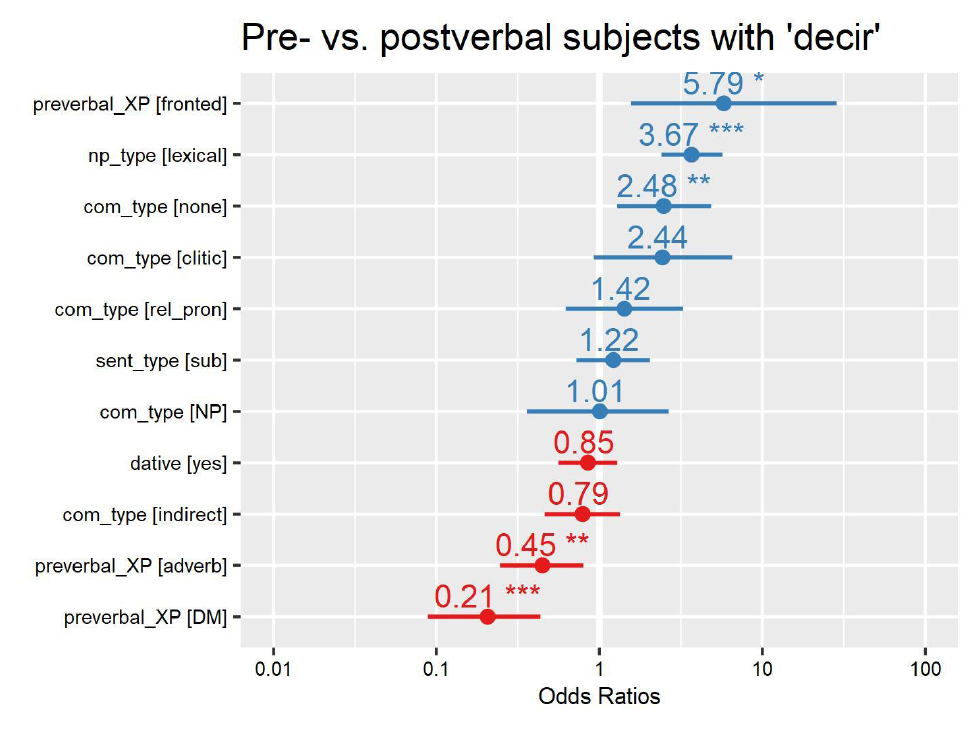
Figure 1. Preverbal and postverbal subjects with decir